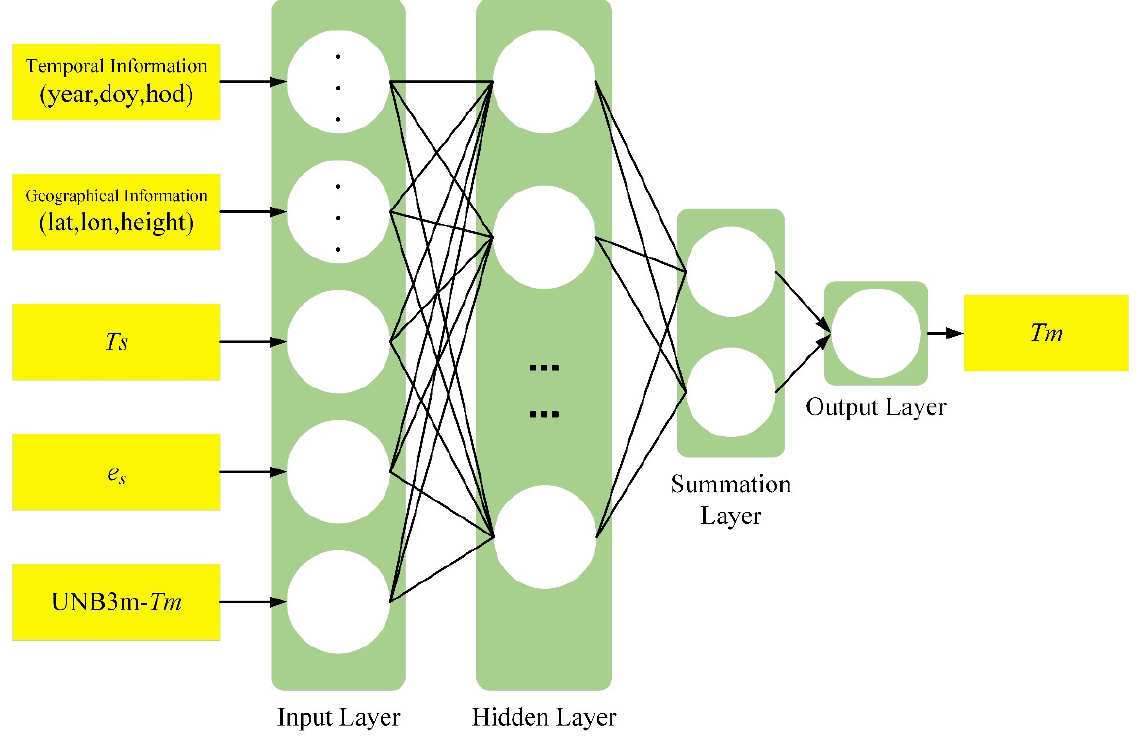
Figure 4. Structural diagram of generalized regression neural network.